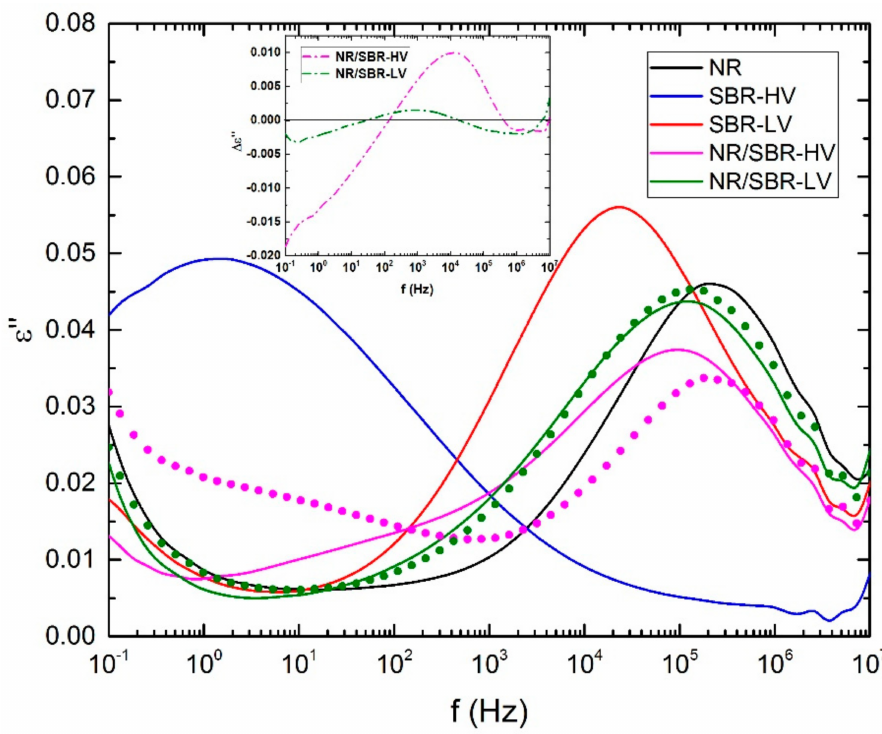
Figure 4. Imaginary permittivity data at 0 ◦ C as a function of frequency for the single elastomers (NR, SBR–HV, and SBR–LV), and NR/SBR–HV and NR/SBR–LV blends. The circles represent the estimated dielectric loss using the weighted average of the individual components. The inset shows the different between the BDS measurements and the estimated values by the weighted average. The samples were cured at 160 ◦